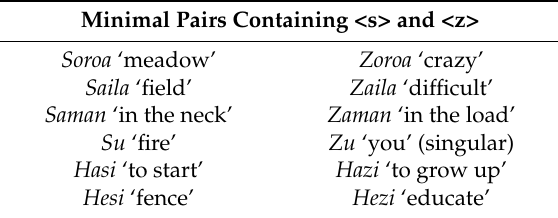
Table 6. Minimal pairs with the letters
 and <z>.